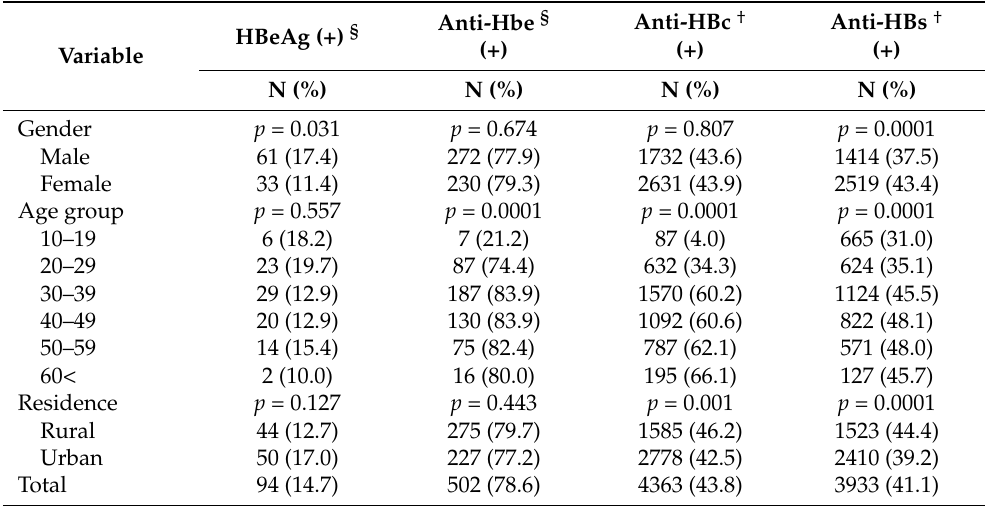
Table 3. Identification of HBV markers among study participants by demographic